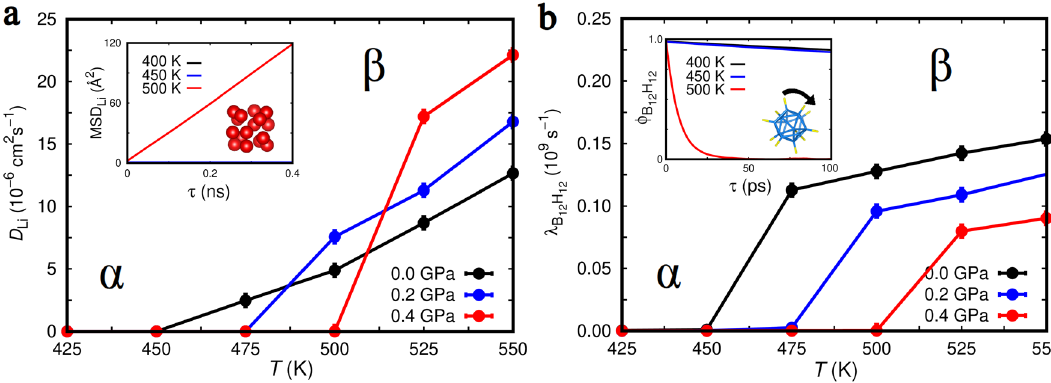
Figure 4. Order parameter changes associated with the T -induced α → β phase transition occurring in bulk Li 2 B 12 H 12 at different pressures (estimated with classical molecular dynamics techniques and the force field reported in work 38 ). ( a ) Computed lithium ion diffusion coefficient, D Li , expressed as a function of temperature and pressure. The inset shows the Li mean-squared displacement (MSD Li ) data employed for the calculation of (cid:31) B D Li at P = 0.2 GPa (“Methods”). ( b ) Estimated (BH) − 2 12 icosahedra reorientational rate, 12 H 12 , expressed as a 2 function of temperature and pressure. The inset shows the (BH) − 12 icosahedra angular auto-correlation function ( φ B 12 H 12 ) data employed for the calculation of (cid:31) B 12 H 12 at P = 0.2 GPa